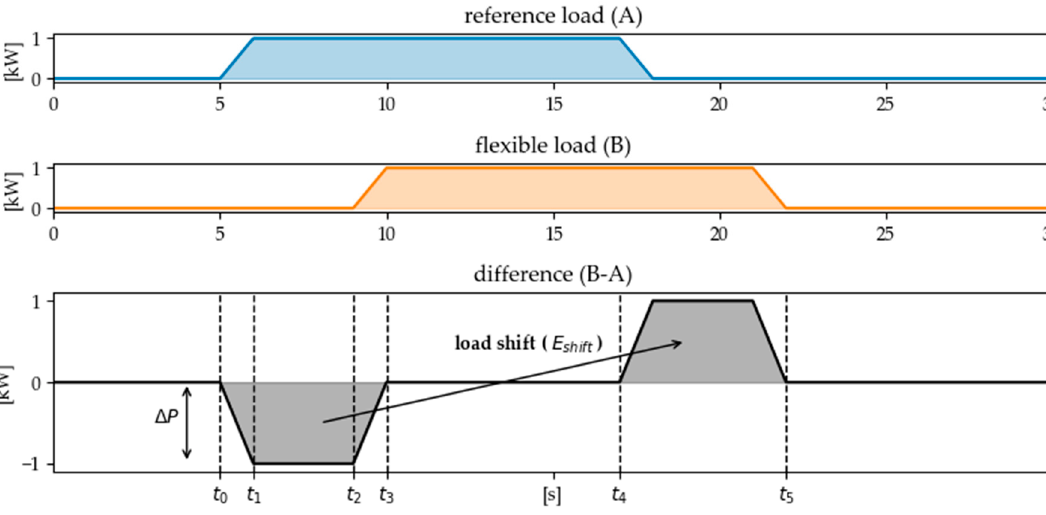
Figure 2. The effectiveness of a flexibility measure from the electricity grids’ point of view is calculated according to [12] from the difference between the load profile in normal operation (reference load) and the one in energy flexible operation (flexible load).